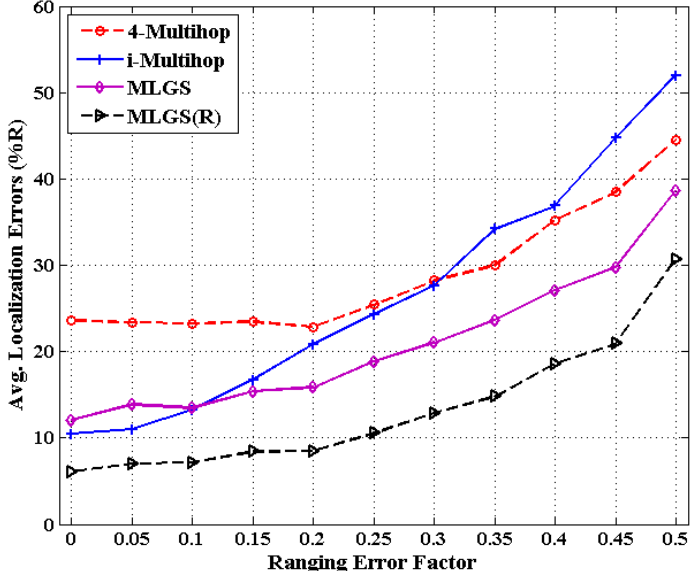
Figure 16. Average localization error versus ranging error factor (isotropic